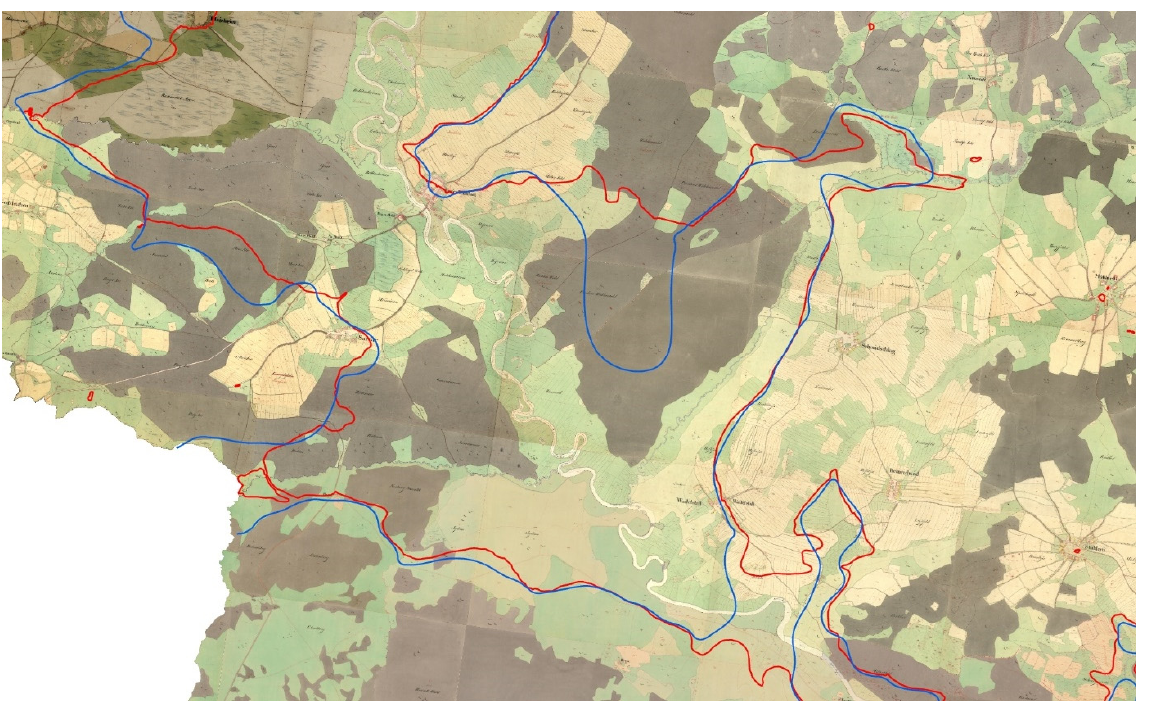
Figure 5. Mismatch between modeled and right shoreline, Source: author’s elaboration.